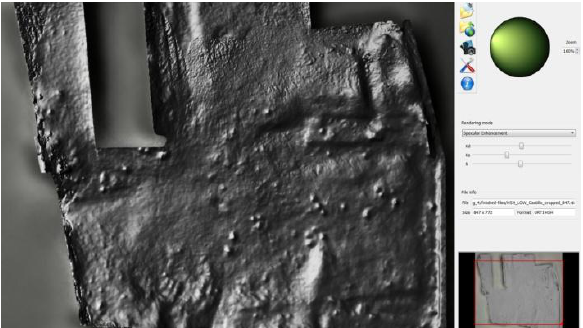
Figure 6: 2.5D Maps renderized with the Specular Enhancement method